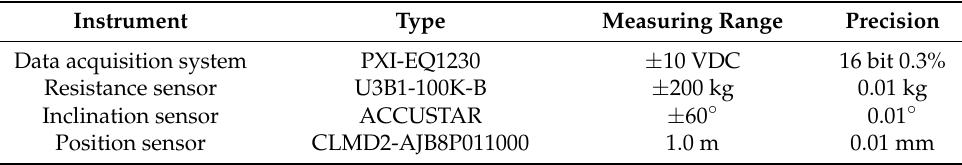
Table 4. Parameters of towing test instruments.